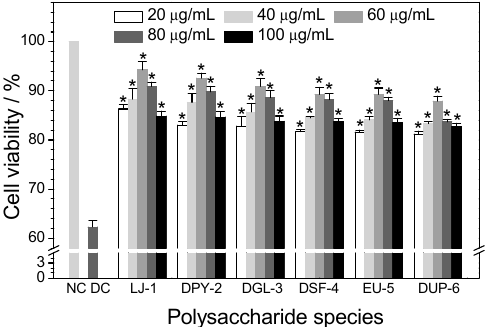
Figure 4. Effect of different polysaccharide concentrations (20, 40, 60, 80, and 100 μ g/mL) on the viability of oxalate-induced damaged HK-2 cells. The cells were incubated with 2.8 mmol/L oxalate for 3 h, and then treated with different concentrations of SPSs for 8 h. Afterwards, cell-viability was determined by CCK-8 assay. Each bar was derived from three independent experiments and data are reported as Mean ± SD. Compared with damaged control group, * indicates p < 0.01. NC: Normal control; DC: Damaged control; LJ-1: Laminaria -1; DPY-2: degraded Porphyra -2; DGL-3: degraded Gracilaria -3; DSF-4: degraded Sargassum -4; EU-5: Eucheuma -5; DUP-6: degraded Undaria -6.